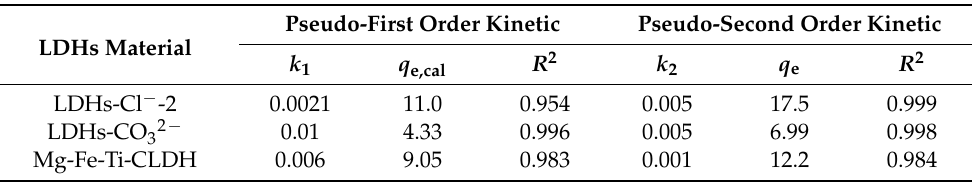
Table 3. Adsorption kinetic models for vanadate adsorption by Mg-Fe-Ti-LDHs-Cl − -2, Mg-Fe-Ti- LDHs-CO 32 − and Mg-Fe-Ti-CLDH.